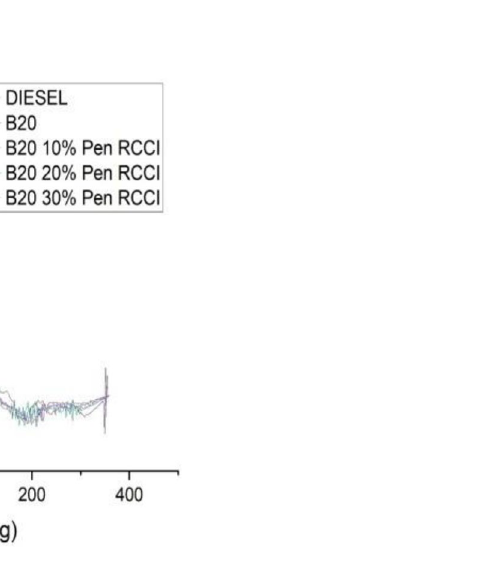
Figure 20. net heat release at 50%